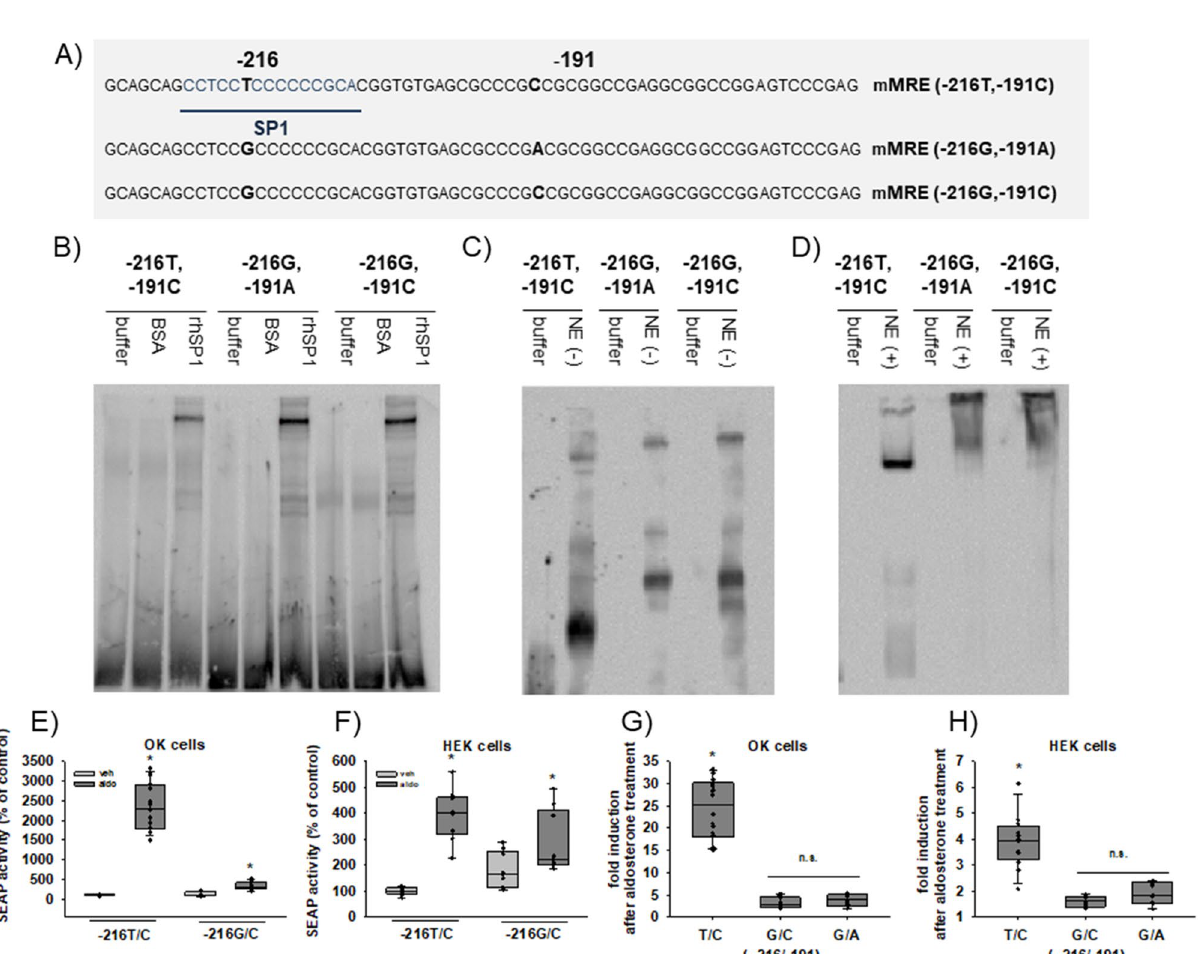
sium channels as indicated in Fig. 2A-D (FPM ≥ 1, Cohen_d ≤ -2 ≥ 2, fold change ≥ 1.50 or ≤ 0.67). To look more specifically at regulation of ion channel expression by EGFR, RNA samples from hearts of EGFR-KO mice and WT control mice were further analyzed in an ion channel qPCR array that tested for 83 ion channel genes and used 5 housekeeping genes for standardization (Fig. 3A). Genes showing significant